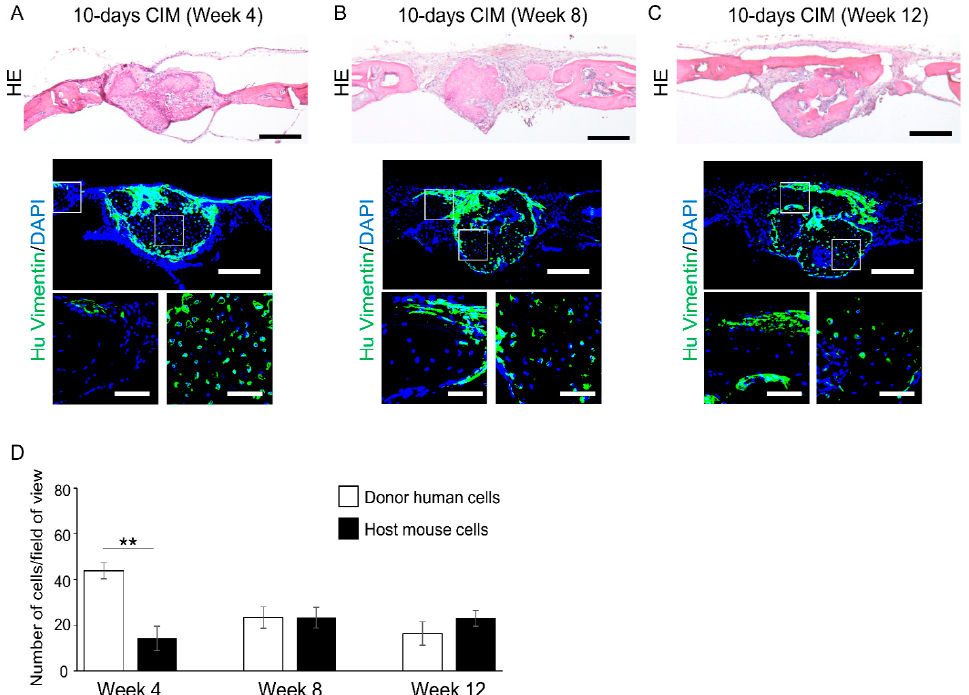
Figure 5. Transplantation of cartilage-like C-MSCs cultured with XF-CIM for 10 days facilitates donor and host cells cooperative bone formation. ( A – C ) C-MSCs cultured with XF-CIM for 10 days were directly transplanted into a SCID mouse cranial defect 1.6 mm in diameter. Animals were sacrificed at 4 ( A ), 8 ( B ), and 12 weeks ( C ) after surgery and the cranial bones were fixed. Semi-serial sections (8 µ m) were stained with HE and immunostained with anti-human vimentin antibody, as indicated. Nuclei were counterstained with DAPI for immunostaining. HE and upper panels of immunostaining images show lower magnification. Bar = 250 µ m. Magnified immunostained images in the boxed regions are indicated at the bottom panels. Bar = 50 µ m. 10-days CIM: transplantation of C-MSCs cultured in XF-CIM for 10 days. All images are representative of six samples. ( D ) Four higher magnification views in the new bone observed at the defect center (descended from C-MSCs) were used for counting of human vimentin-positive (donor human) and -negative (host mouse) cells. Values are expressed as means ± S.D. of the four views tested for each group. ** p <